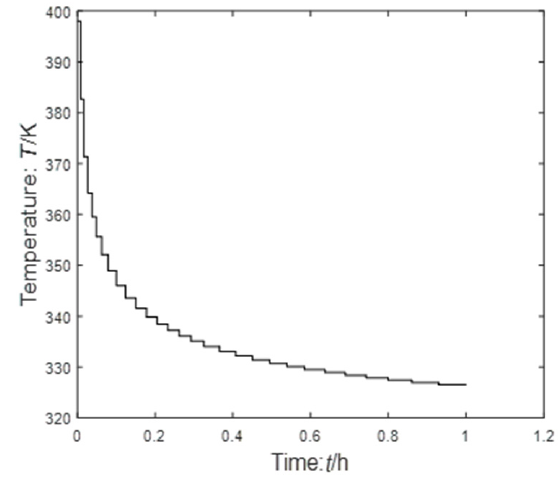
Figure 3. Optimal temperature control trajectory ( N = 20).